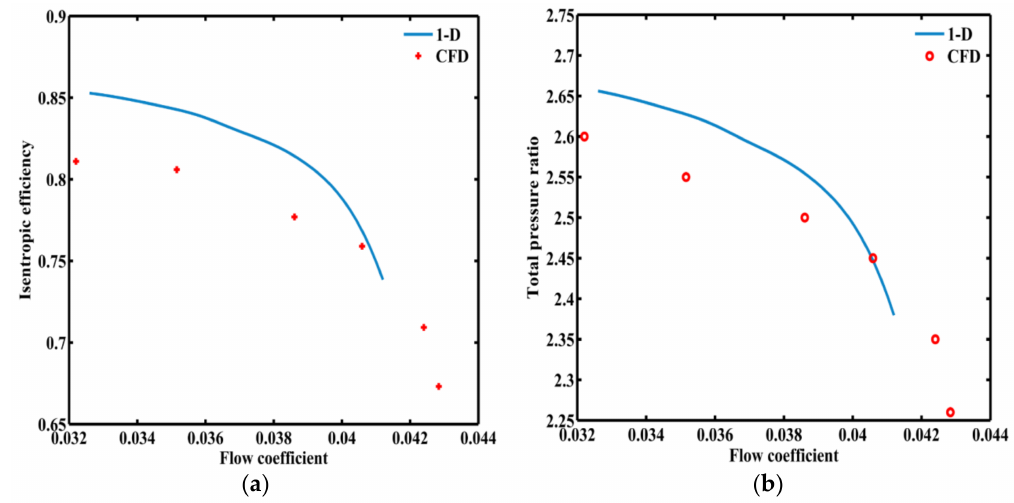
Figure 15. Centrifugal compressor performance (1 MWe). ( a ) Efficiency; ( b ) Pressure